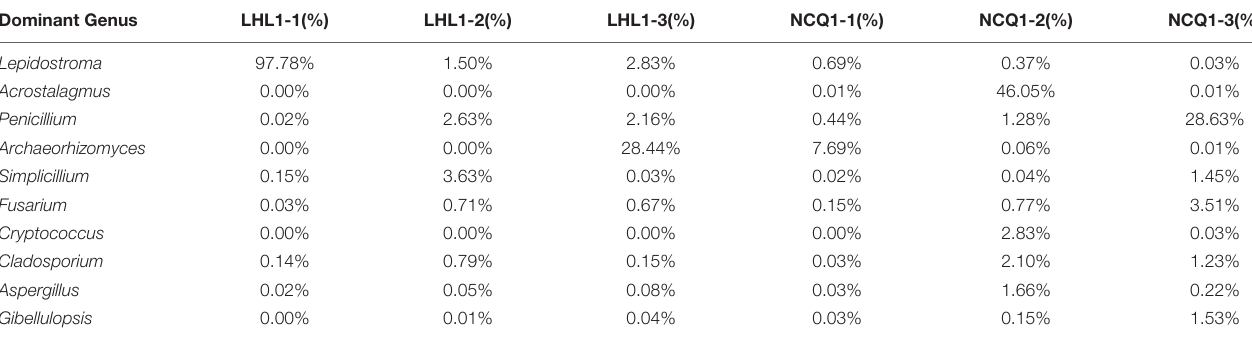
FIGURE 7 | Relative abundance of the thirty most abundant microbial phyla and Venn diagrams showing shared OTU diversity among the samples. (A) The relative abundance for each sample is shown as a proportion of 100%. Fungal phyla are colored according to the legend on the right. (B) Fungal OTUs. (C) The relative abundance for each sample is shown as a proportion of 100%. Bacterial phyla are colored according to the legend on the right. (D) Bacterial OTUs. TABLE 1 | Relative abundance of dominant fungi among samples at the genus